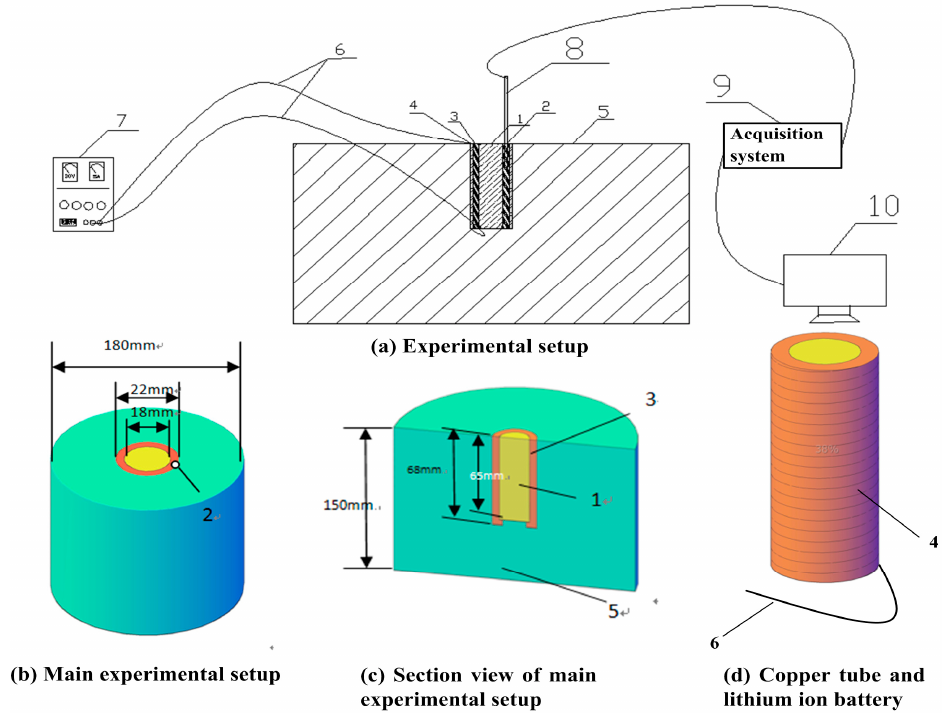
Figure 1. Experimental setup. 1: 18650 lithium-ion batteries; 2: thermocouple hole; 3: copper pipe;